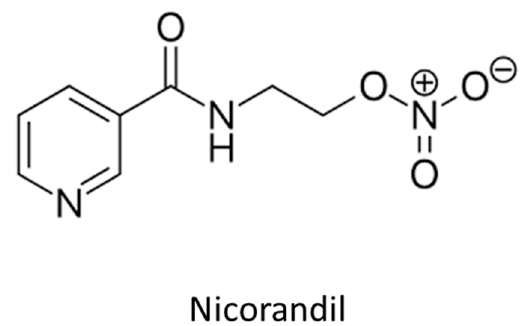
Figure 3. Figure 3. Nicorandil.